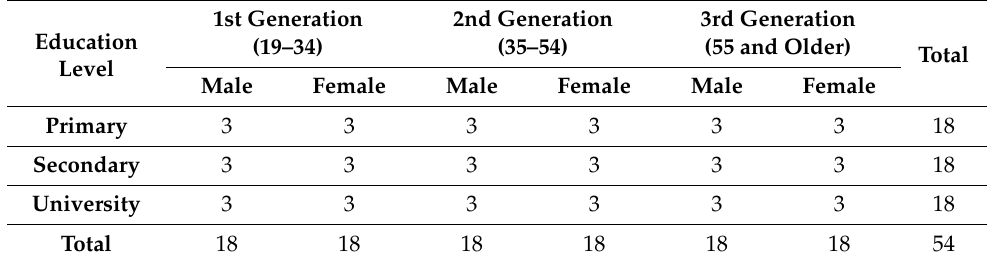
Table 1. Distribution of informants according to age, gender, and educational